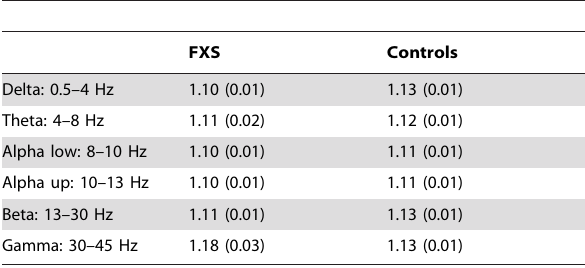
Table 1. Results of the small-world index ‘‘ S ’’ in FXS and controls in the six EEG frequency